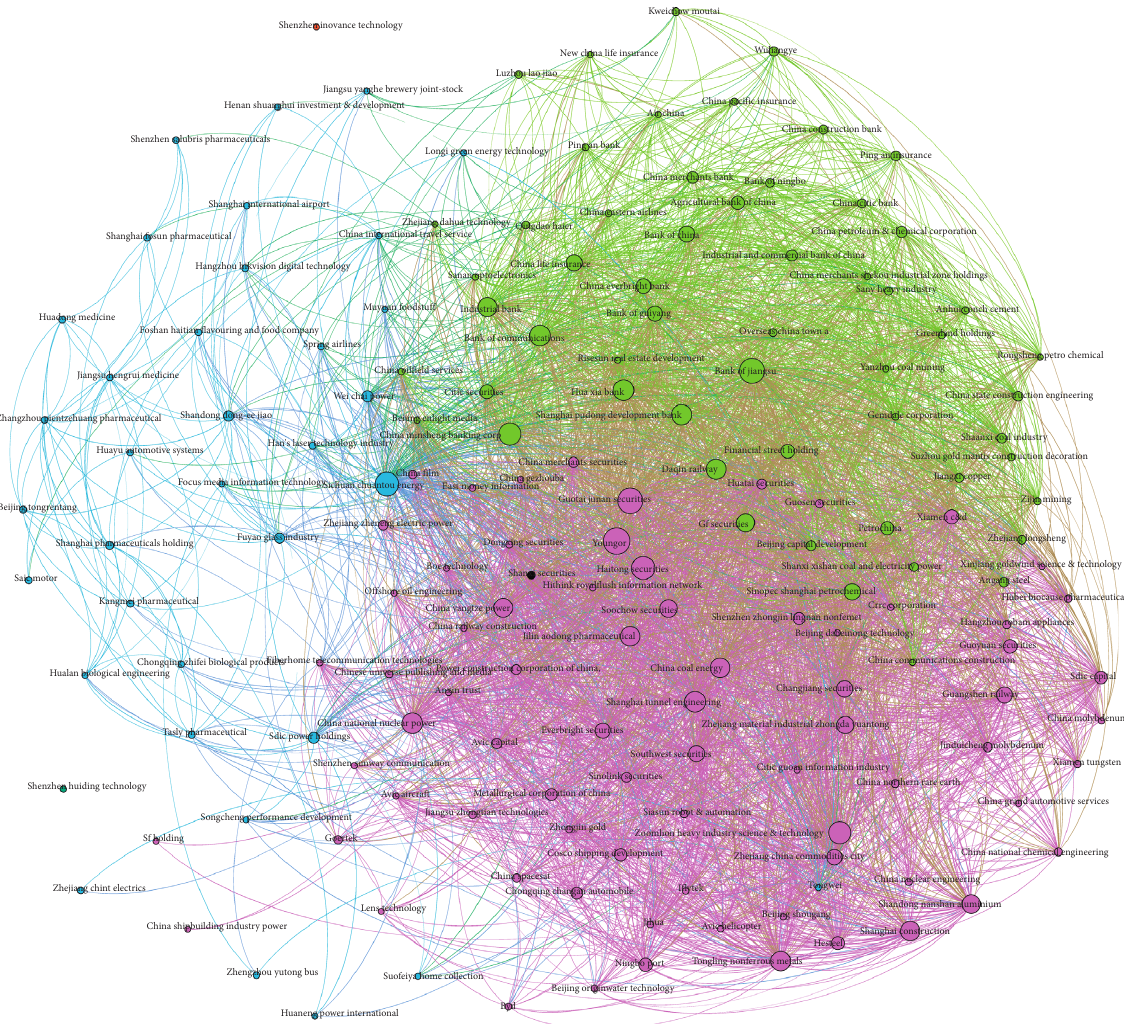
Figure 5: Complex network of CSI 300 during